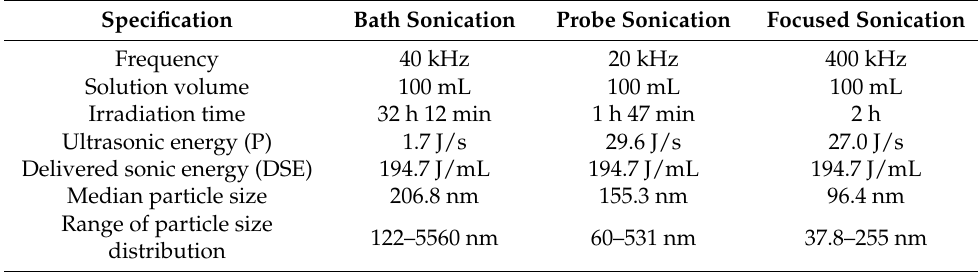
Table 1. Specifications of the three types of sonication methods.